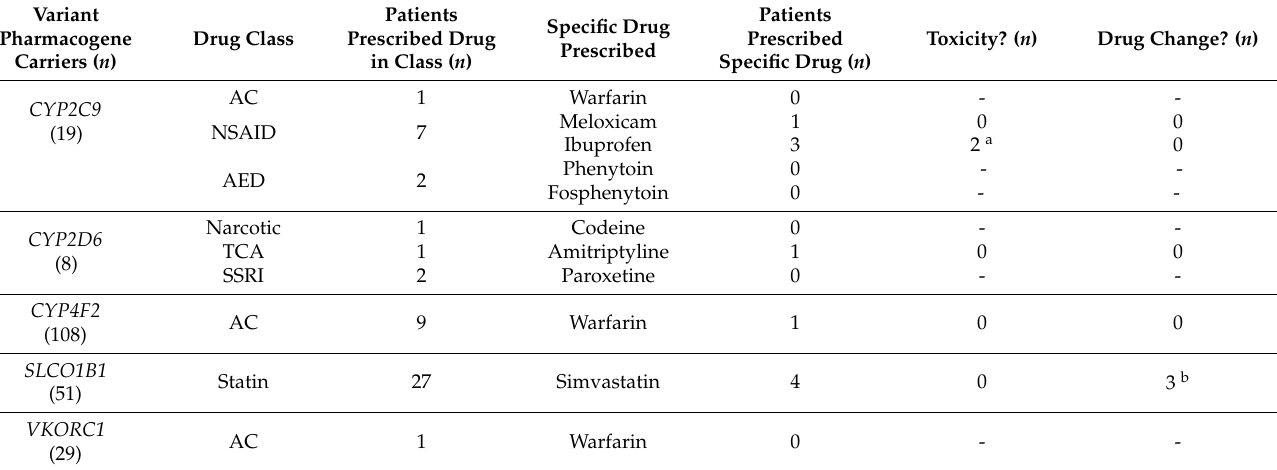
Table 5. Clinical impact after identification of pharmacogenomic